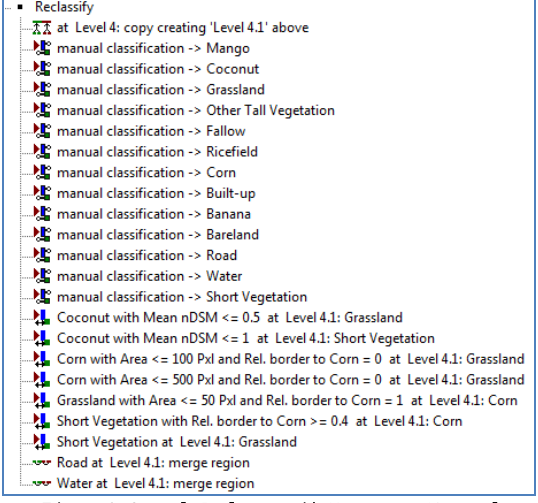
Figure 6. Sample Rulesets with Numerous Manual Classification and Rule-Based Refinements